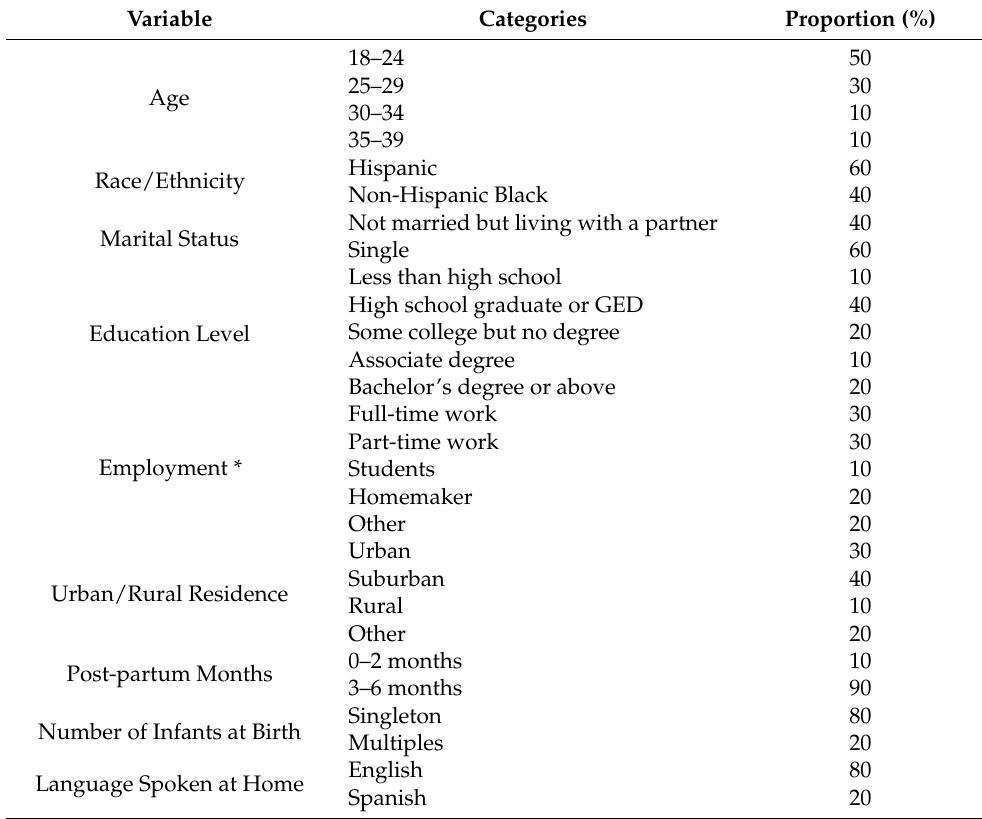
Table 1. Characteristics of WIC Mothers Interviewed (n =